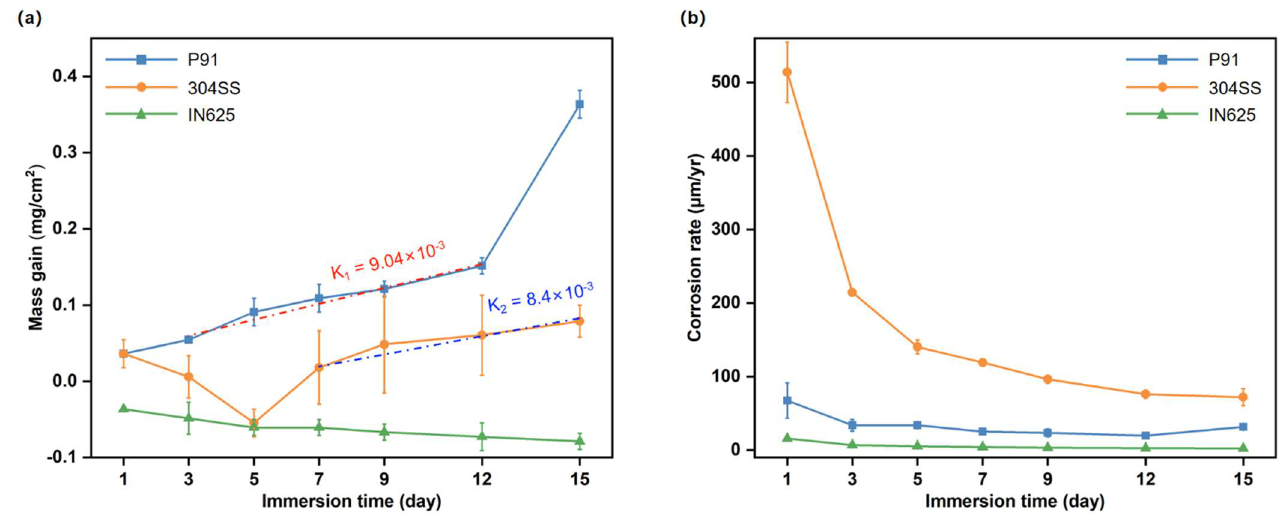
Figure 3. ( a ) Mass gain and ( b ) corrosion rate as a function of immersion time for P91, 304SS, and IN625 alloys in Solar Salt at 565 °C.